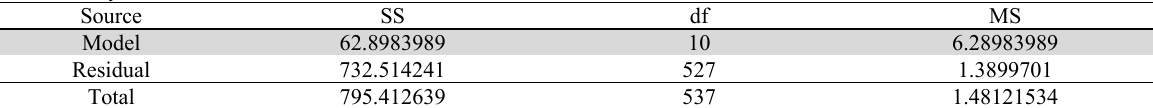
The summary of ANOVA